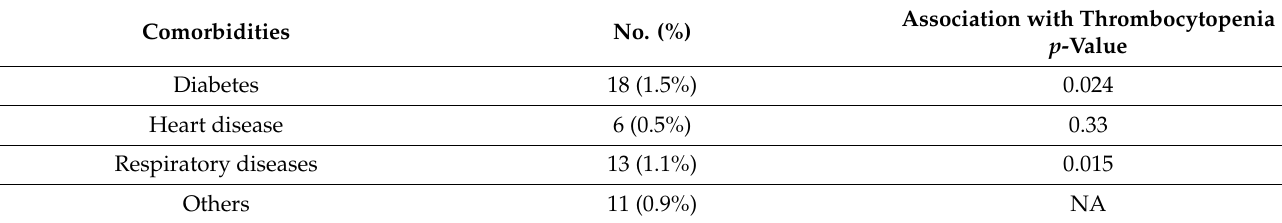
Table 1. Comorbidities among enrolled patients.